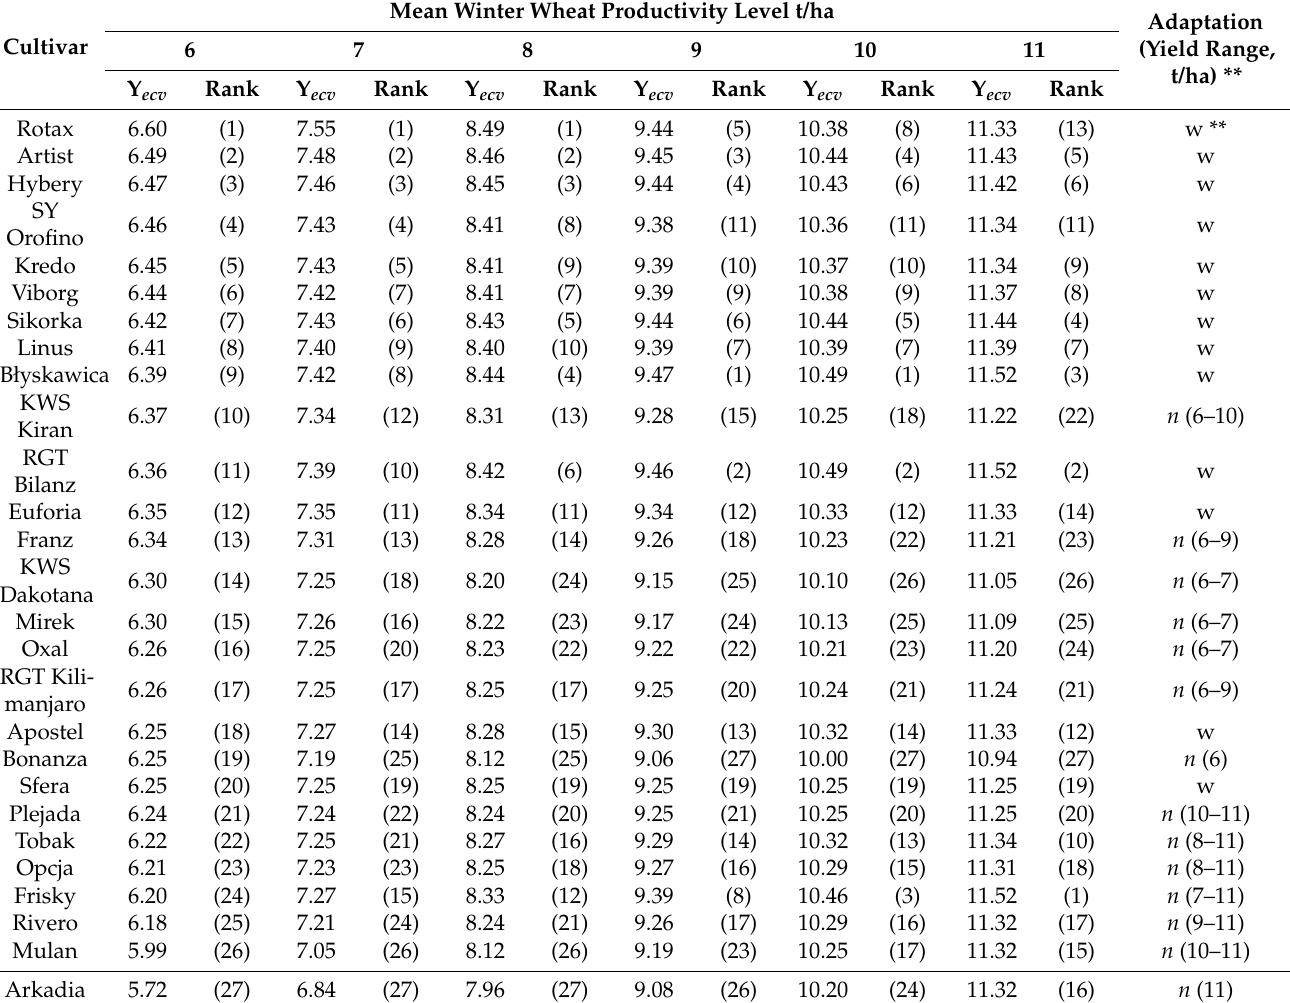
analysis, with estimated yield and ranks at each average productivity level, is available in the Supplementary Table S4. Table 3. Estimated cultivar yield and their ranks in the environments’ particular productivity levels. Mean Winter Wheat Productivity Level t/ha Cultivar